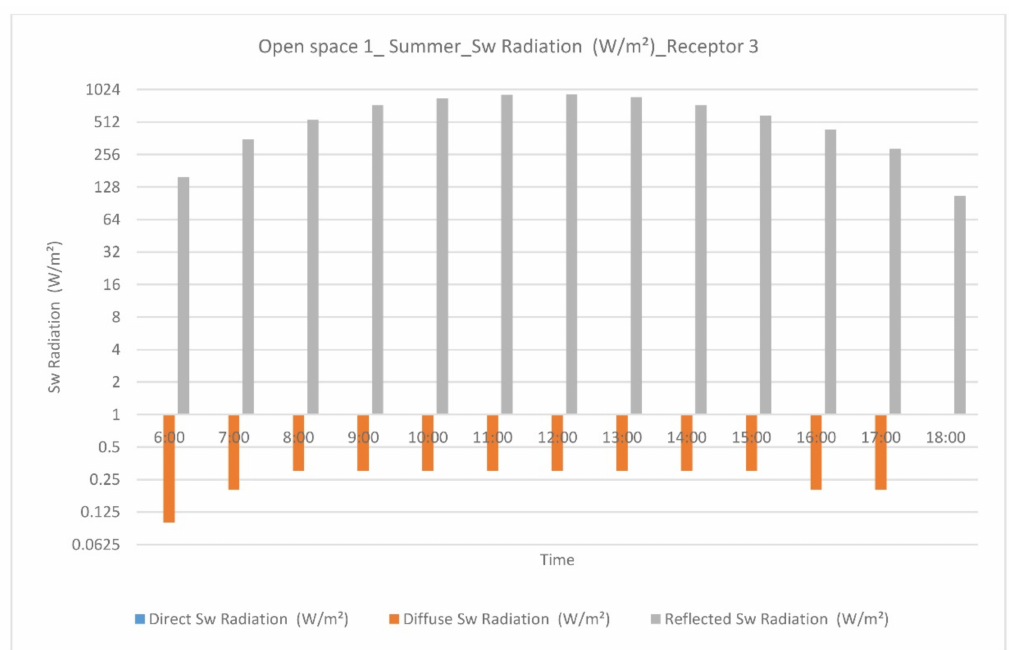
Figure A1. Open space 1 solar radiation in summer at receptor 3.